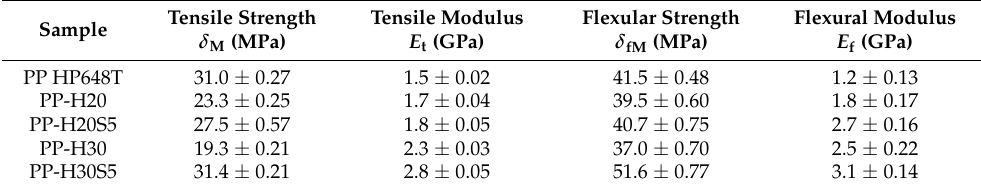
Table 6. Tensile and flexular properties of PP/grass